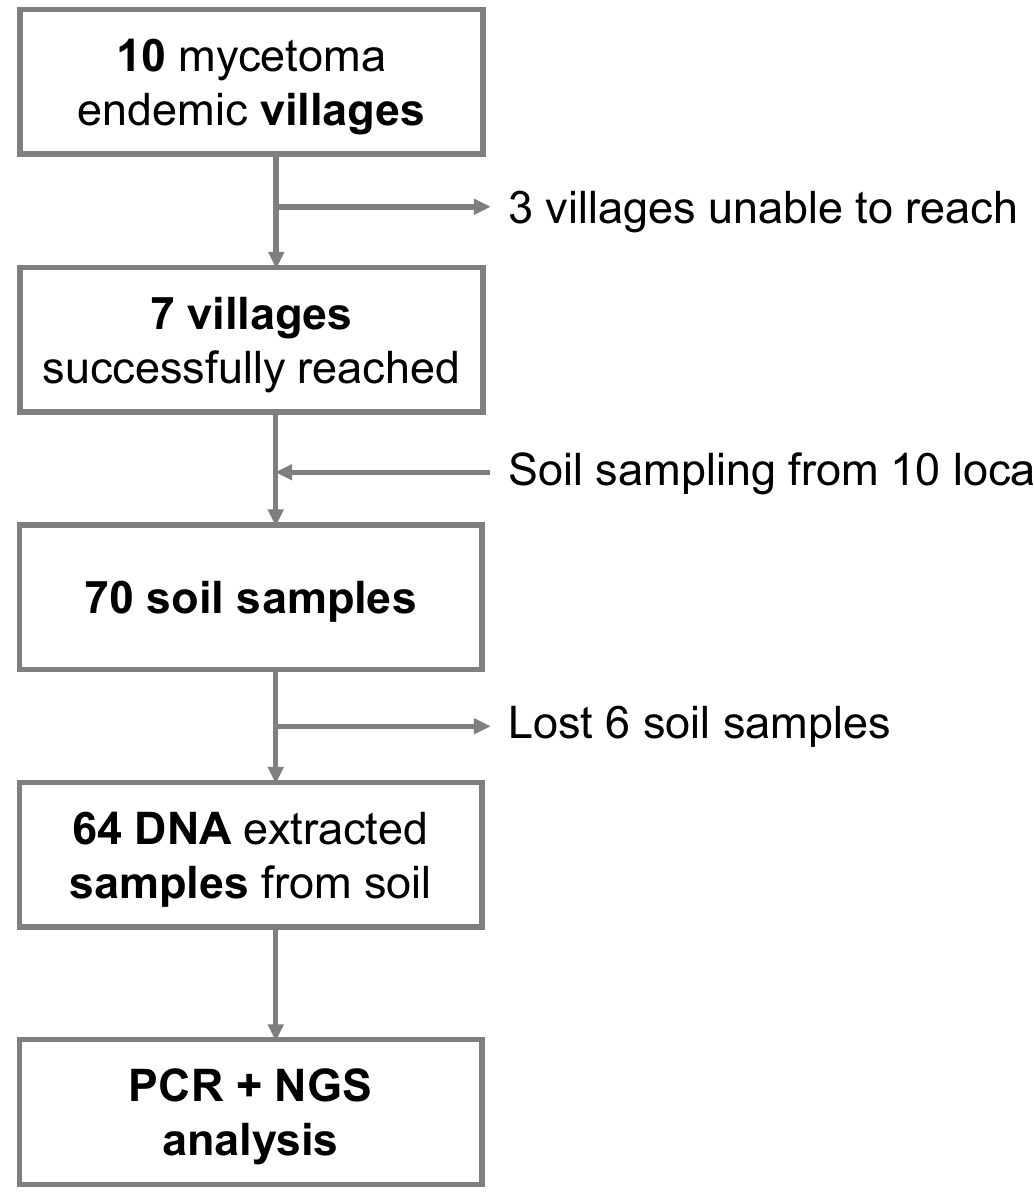
Fig 3. Schematic diagram of soil sampling prior to NGS